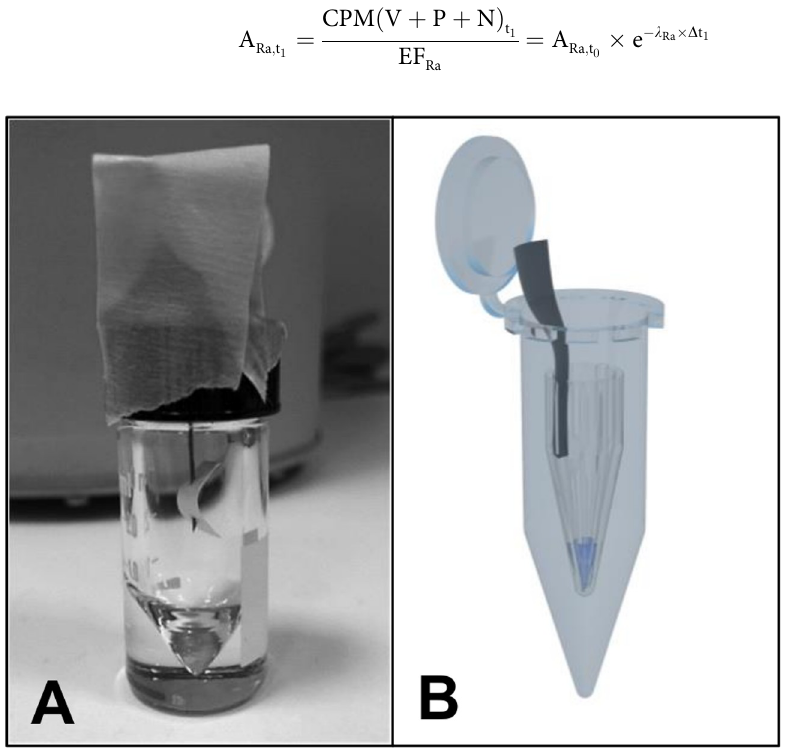
Fig 2. Experimental setups to investigate 220 Rn diffusion from open sources to air. A 3 mL glass micro reaction vessel (A) and a sealed 5 mL Eppendorf tube (shown open for illustrative purposes) containing a capless 1.5 mL Eppendorf tube (B) were used in separate